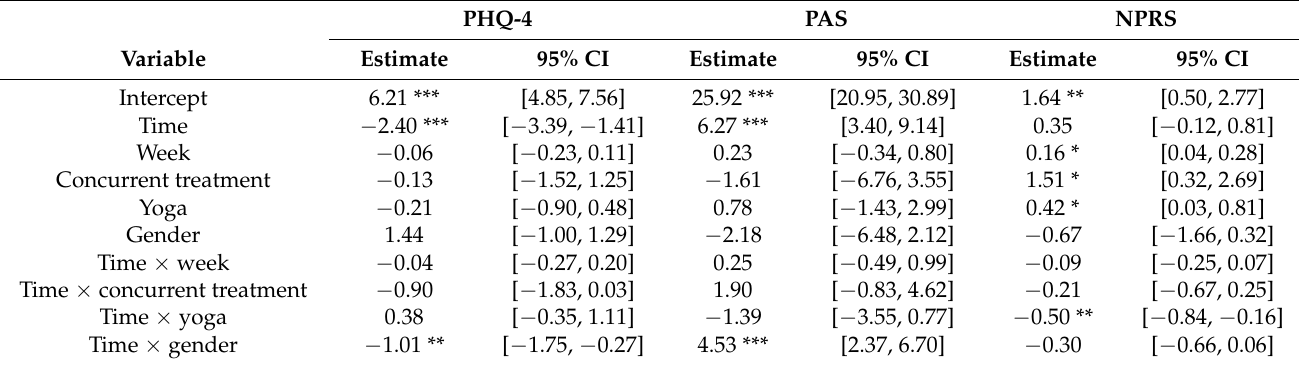
Table 3. Final multi-level analyses examining pre–post-session scores for depression/anxiety, positive affect, and pain rating. PHQ-4